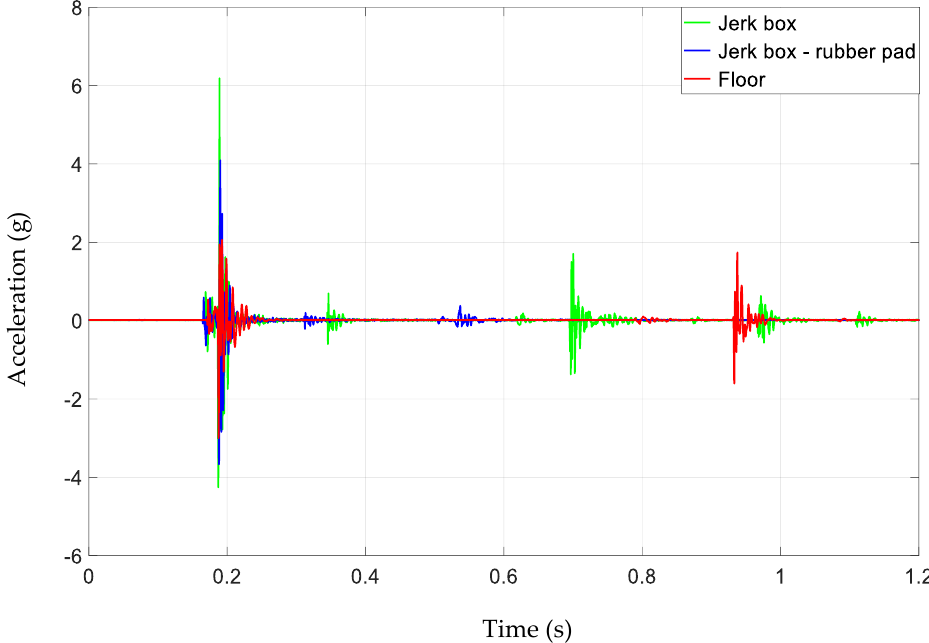
Figure 7. Acceleration generated at the floor during a barrel drop of 60 kg from the overhead locked position.